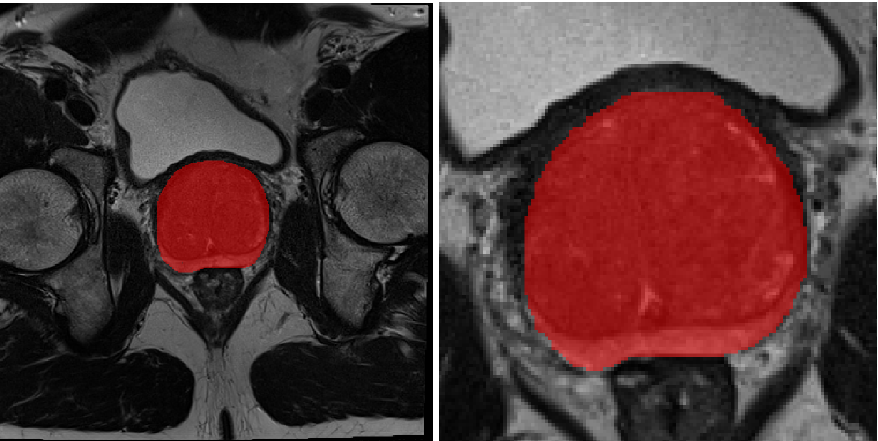
Figure 1. Comparison between original and cropped volumes. Both images correspond to the middle slice of the volumes. The image on the left represents the original full size slice, while the image on the right represents the cropped version.